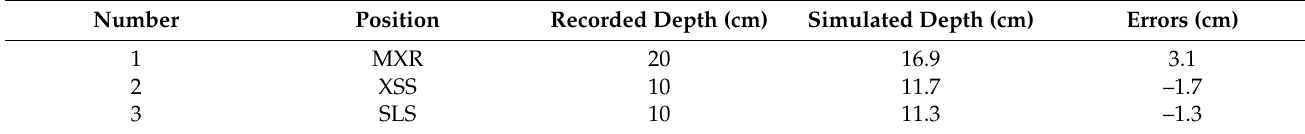
Table 4. Statistics of the maximum inundation depth of the 2 July 2020 rainfall